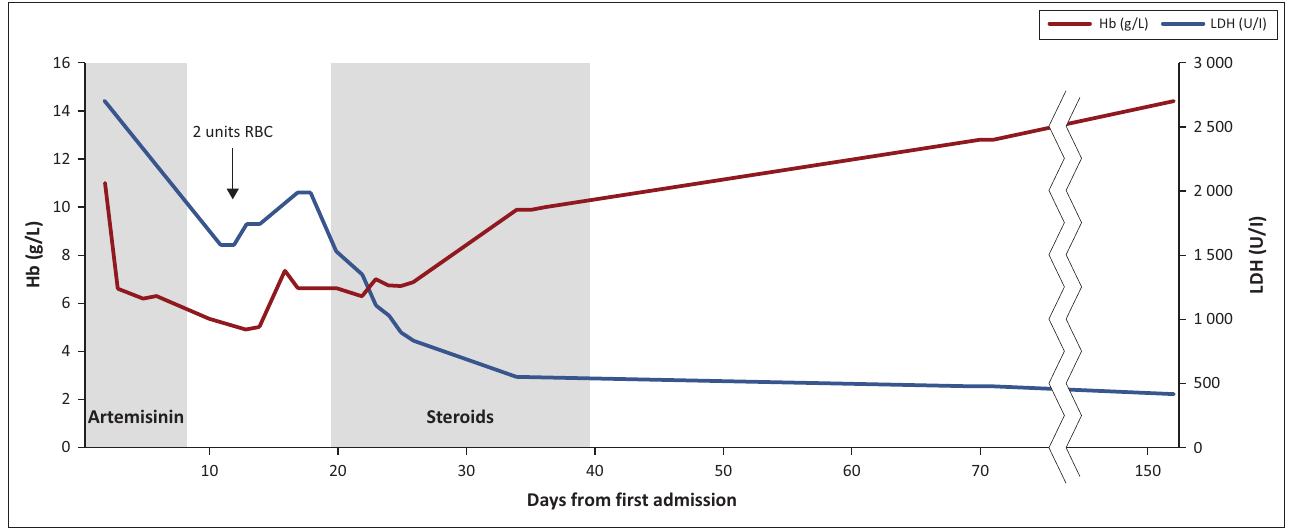
FIGURE 1: A timeline depicting trends in haemoglobin, lactate dehydrogenase in relation to artemisinin and steroid